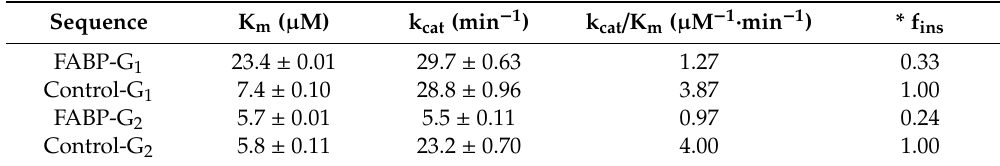
Table 1. Steady-state kinetic parameters for insertion of dCTP opposite unmodified FABP − dG adduct with Kf-exo −